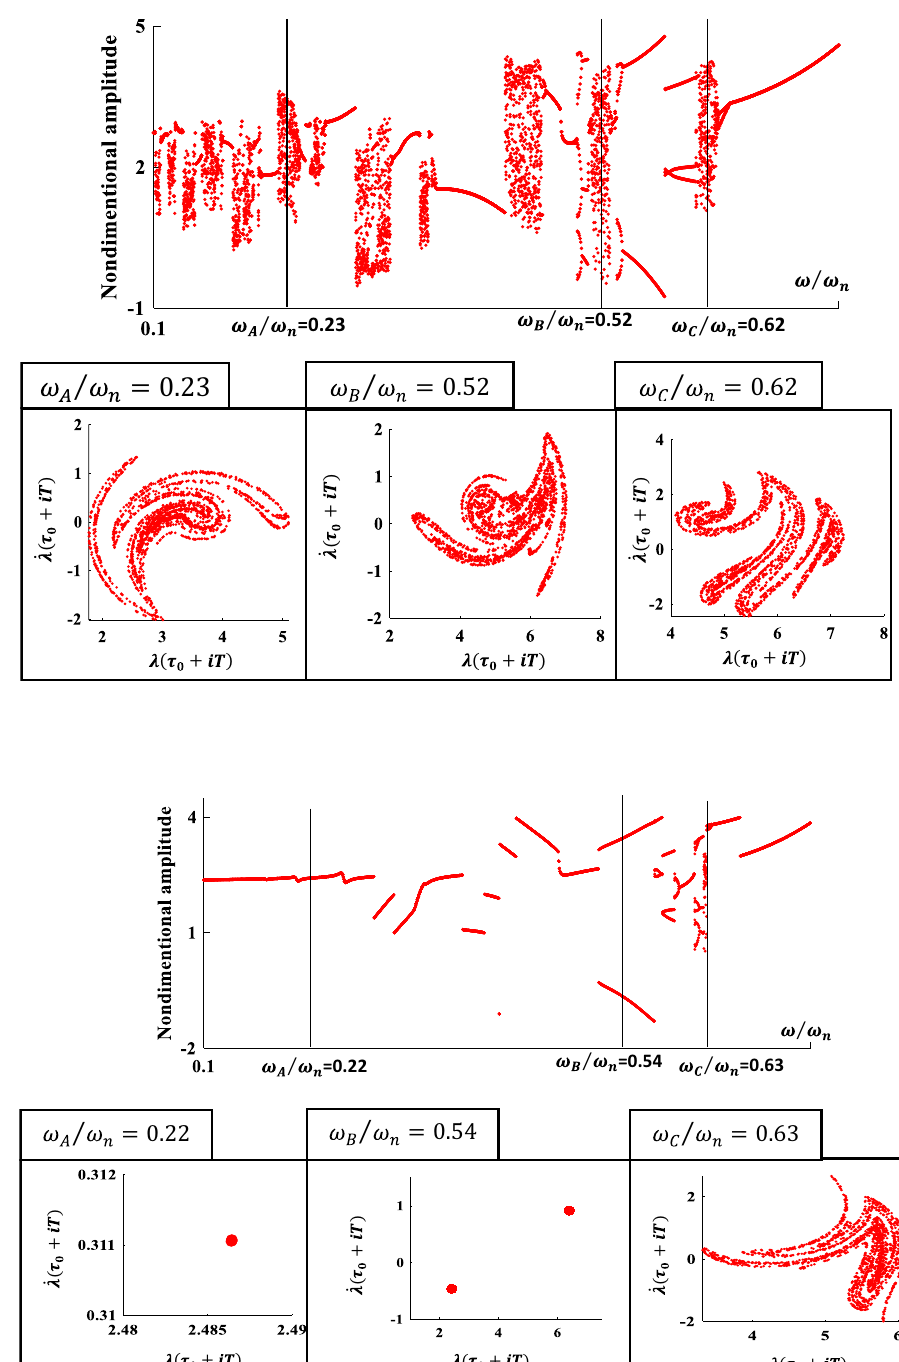
Fig. 6 Bifurcation and cor- responding Poincaré map for = 1 n f